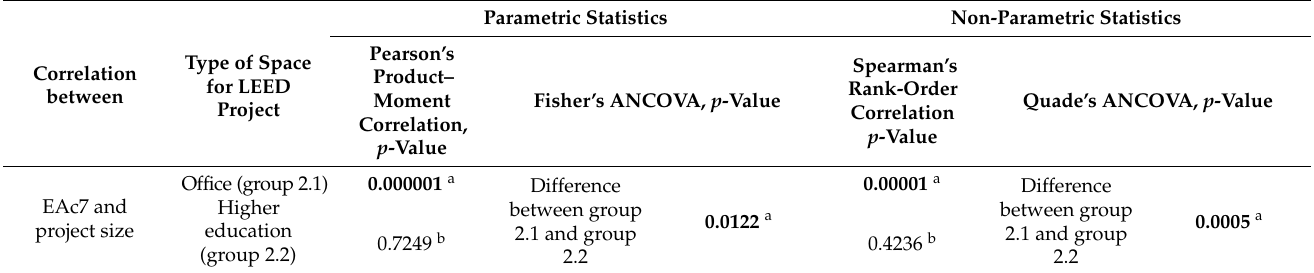
Table 6. Case 2: comparisons of EAc7 (Optimize Energy Performance) credit achievement for groups 2.1 and 2.2 considering project size in LEED-NC v4 gold